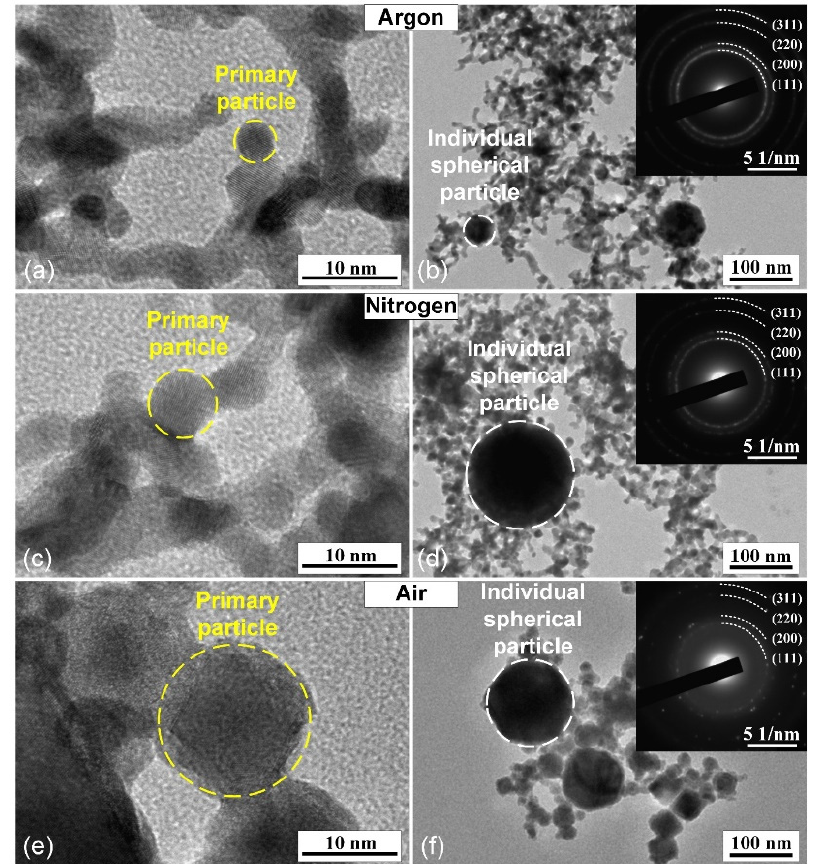
Figure 2. TEM images of aggregates, primary and individual spherical platinum nanoparticles (PtNPs) synthesized by SDG in various gases: ( a , b ) Ar, ( c , d ) N 2 , and ( e , f ) air. The insets show the corresponding electron diffraction patterns.